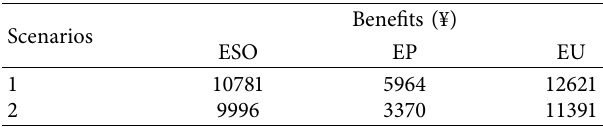
Table 6: Income comparison of each player under diferent scenarios.